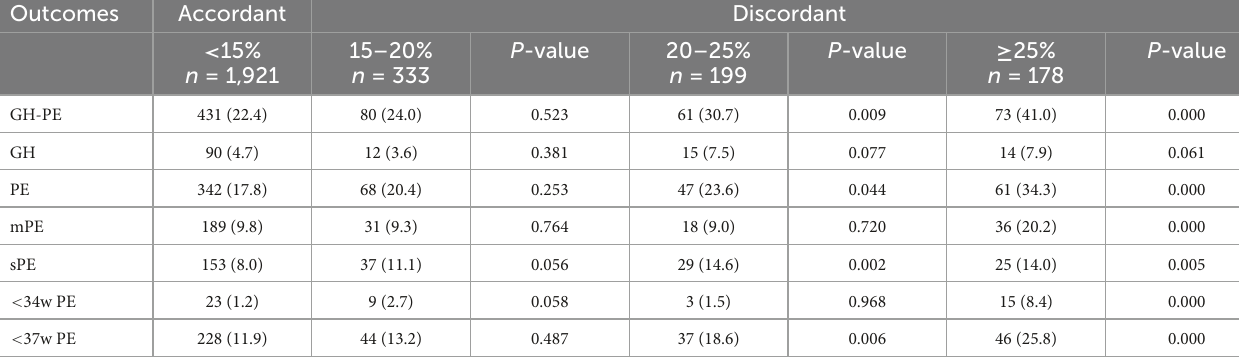
TABLE 2 Maternal GH-PE outcomes of different degrees of intertwin BWD. Outcomes